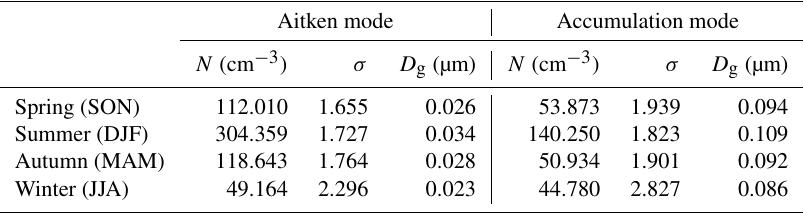
Figure 14. Seasonal log-normal fitted size distribution of aerosol particles originating from the South Pacific Ocean, ranging from 0.01 to 0.3µm (Case IV). Table 2. Seasonal size distribution lognormal fitting parameters for the Aitken and accumulation mode of aerosol particles originating from a Case IV scenario. N , σ , and D g refer to the number concentrations, a standard deviation, and the geometric mean diameter,